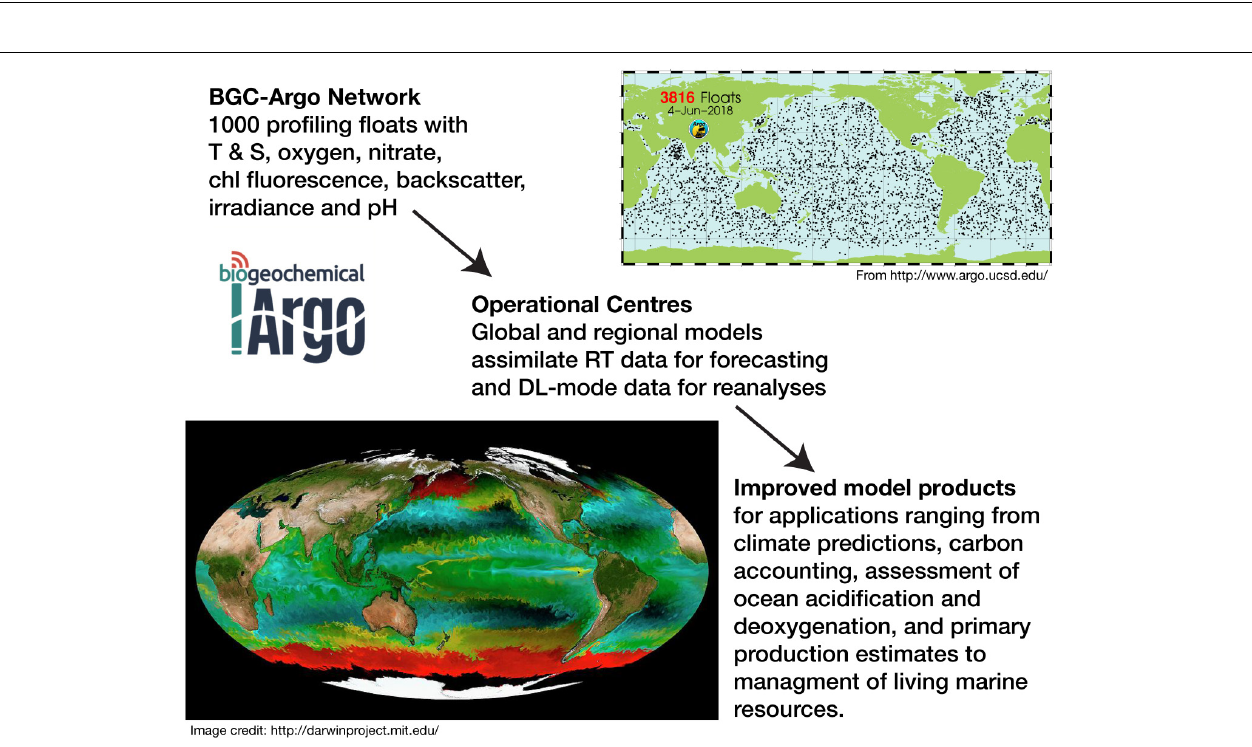
FIGURE 13 | Easily accessible and appropriate-for-purpose data products derived from Argo are required to maximize the societal value of the Argo dataset.